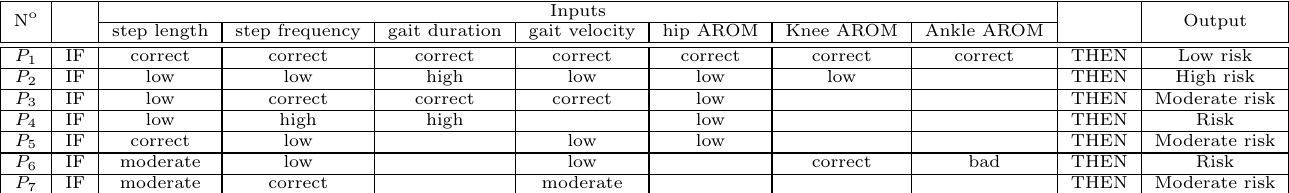
Table 1: Rules of the inference